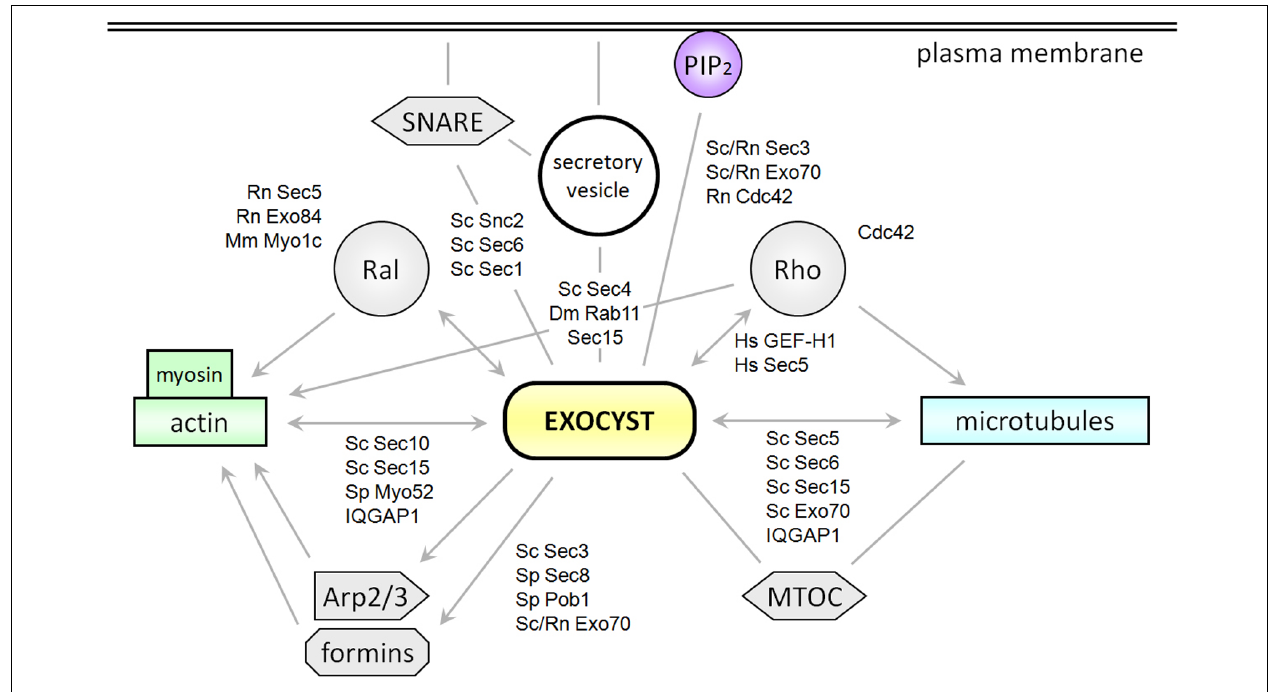
microtule-organizing center (MTOC) and phosphatidylinositol 4,5-bisphosphate (PIP 2 ) at the plasma membrane. Dm, Drosophila melanogaster ; Mm, Mus musculus ; Hs, Homo sapiens Rn, Ratus norwegicus ; Sc, Saccharomyces cerevisiae ; Sp, Schizosaccharomyces pombe